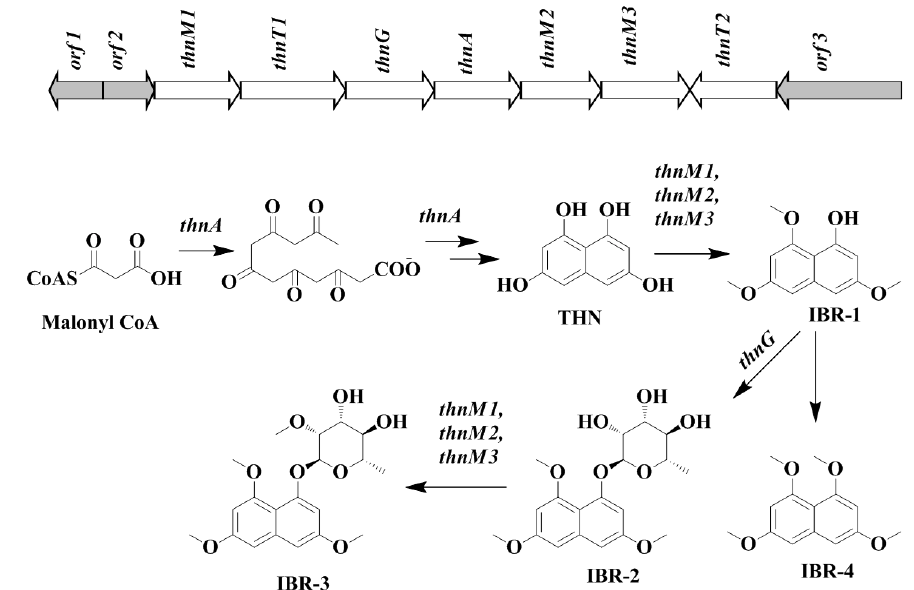
Figure 3. The putative biosynthetic gene cluster and proposed biosynthetic mechanism of compound